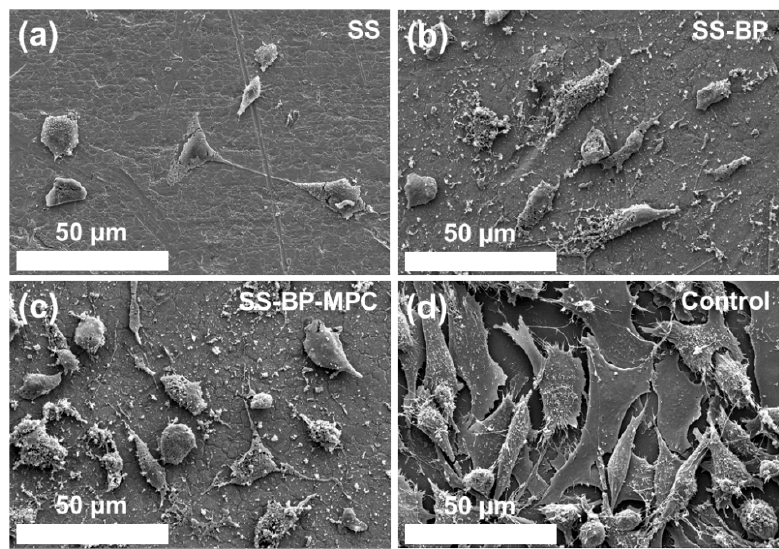
Figure 10. FESEM micrographs for MC3T3-E1 cells co-cultured on surfaces of ( a ) pristine SS, ( b ) SS-BP, and ( c ) SS-BP-MPC composites for four days and compared with ( d ) control group.